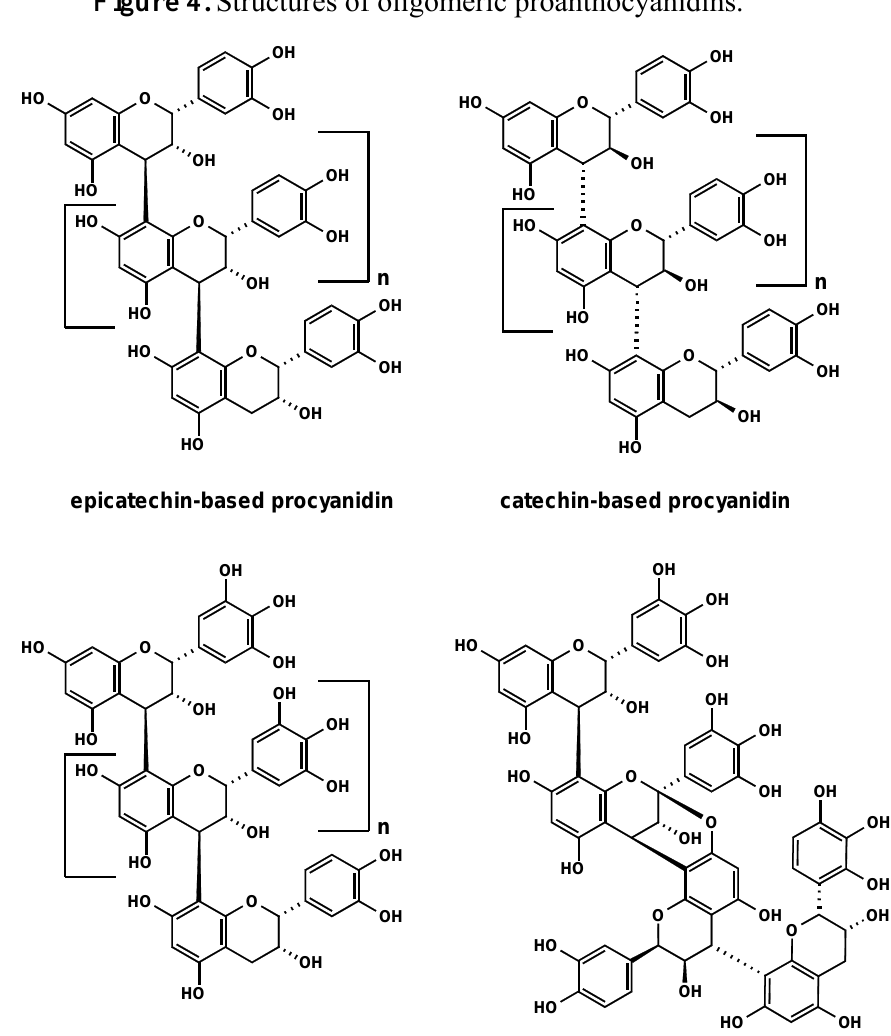
Figure 4. Structures of oligomeric